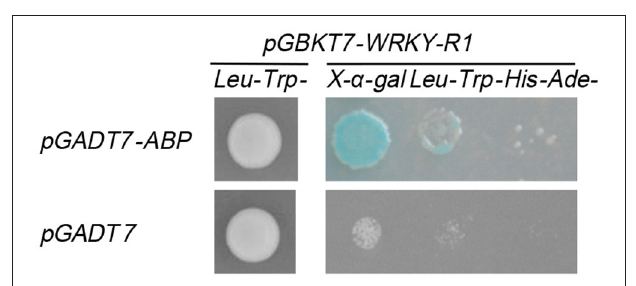
FIGURE 8 | NtWRKY-R1 strongly interacted with ABP.